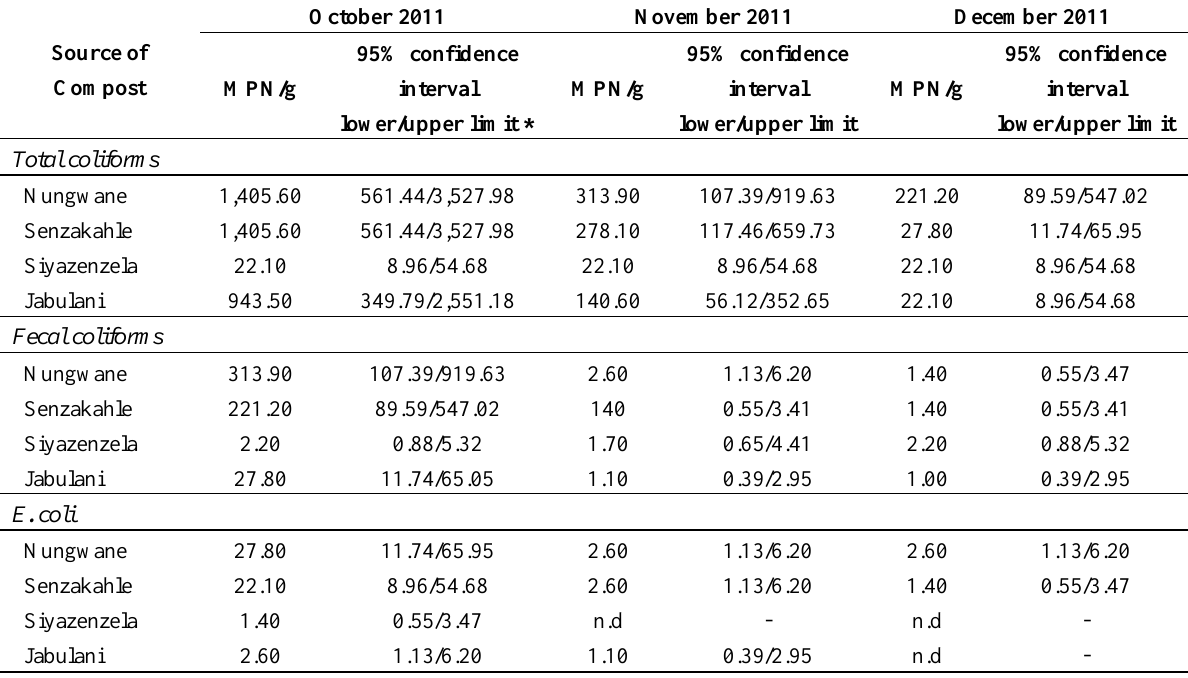
Table 5. MPN per g of compost for total and fecal coliforms as well as E. coli in the compost of the different farmer groups for the months of October, November and December